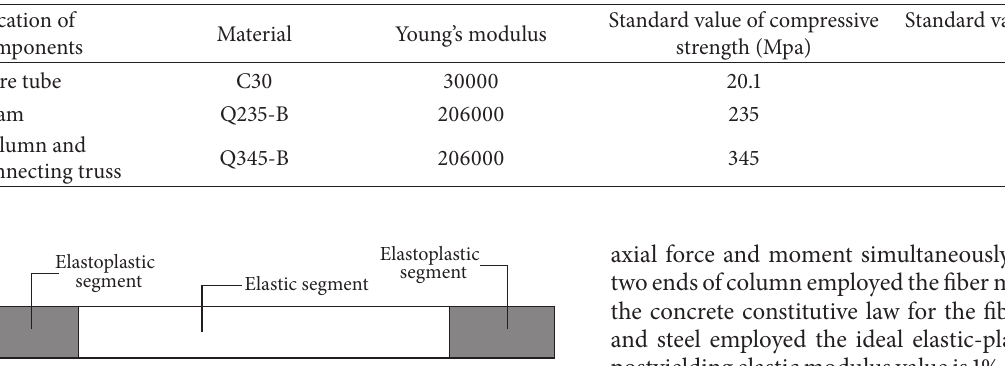
Table 1: Material properties of structural components.